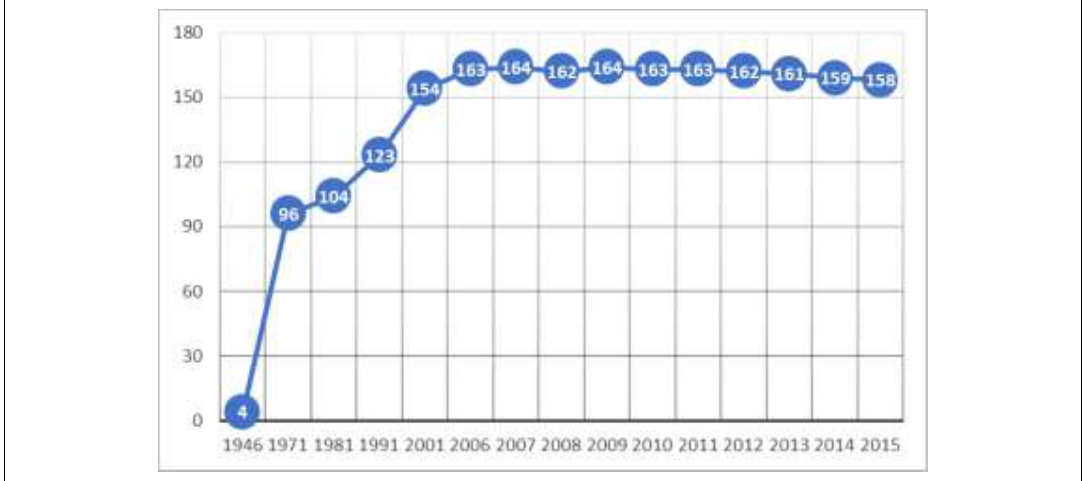
Figure 1 . Number of Universities in Taiwan 1946 – 2015 (National Statistics ROC,